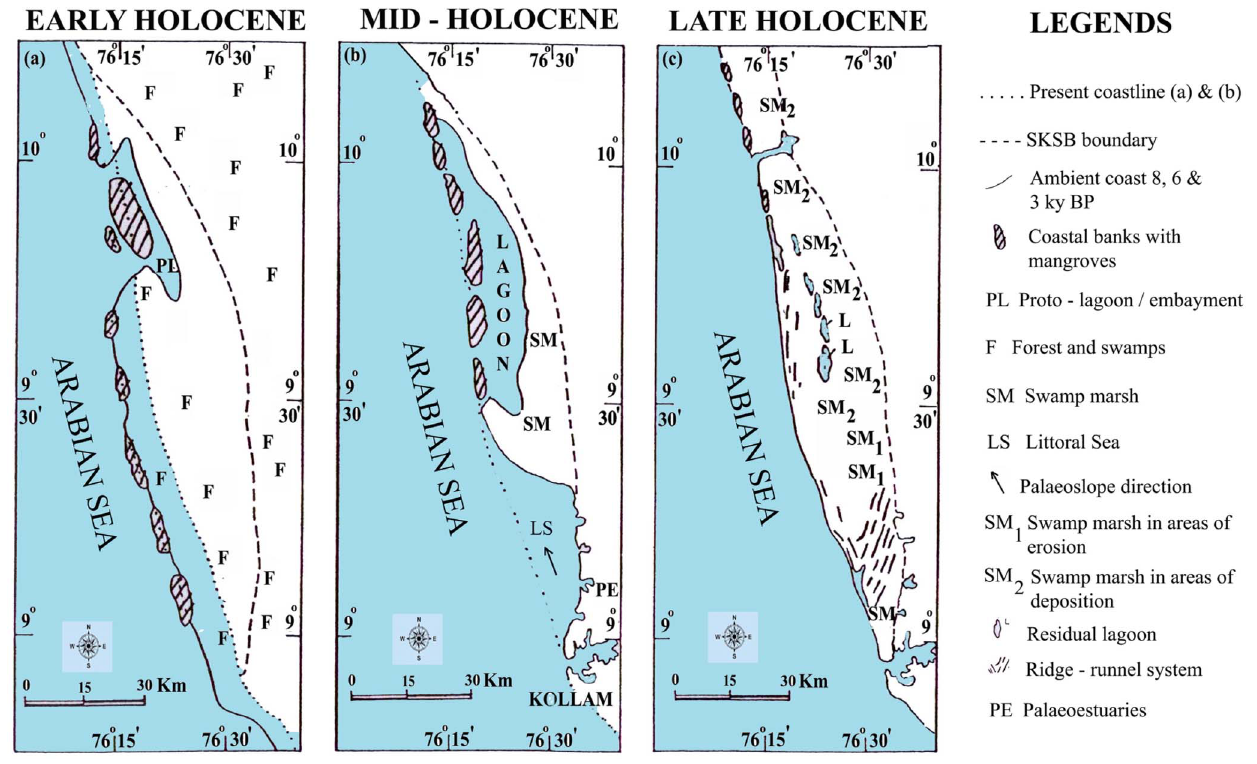
Figure 10. Ecogeomorpholgical evolution of southwest coast of India during Holocene. (a) 9–8 k yrs BP; (b) 7–6 k yrs BP; (c) 3 k yrs BP.